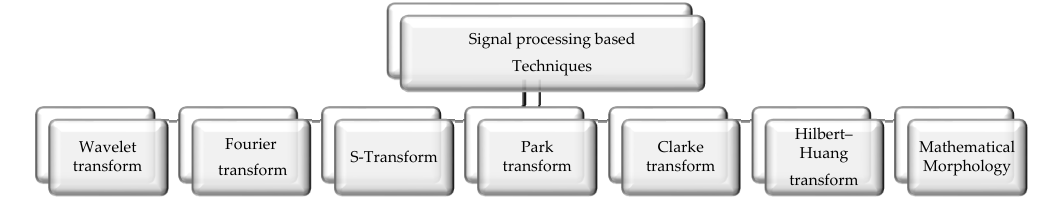
Figure 3. Signal processing-based fault detection and classification methods.